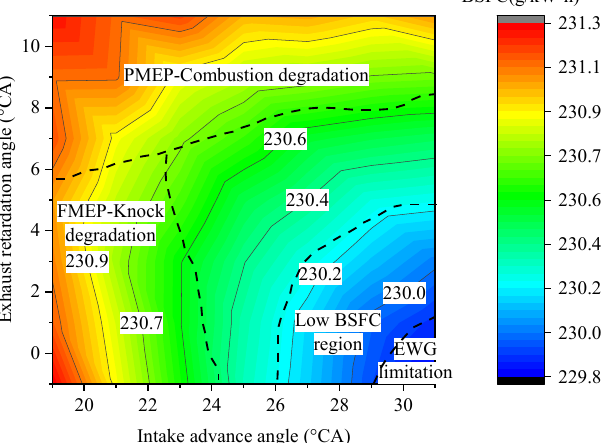
Figure 24. BSFC versus the combined change of intake advance angle and exhaust retardation angle (point of operation: n = 3000 rpm, BMEP = 10 bar, CA50 = 8 °CA).